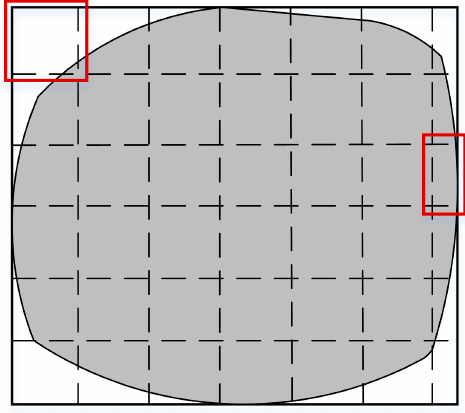
Figure 6. Edge blocks with slight computation burden.